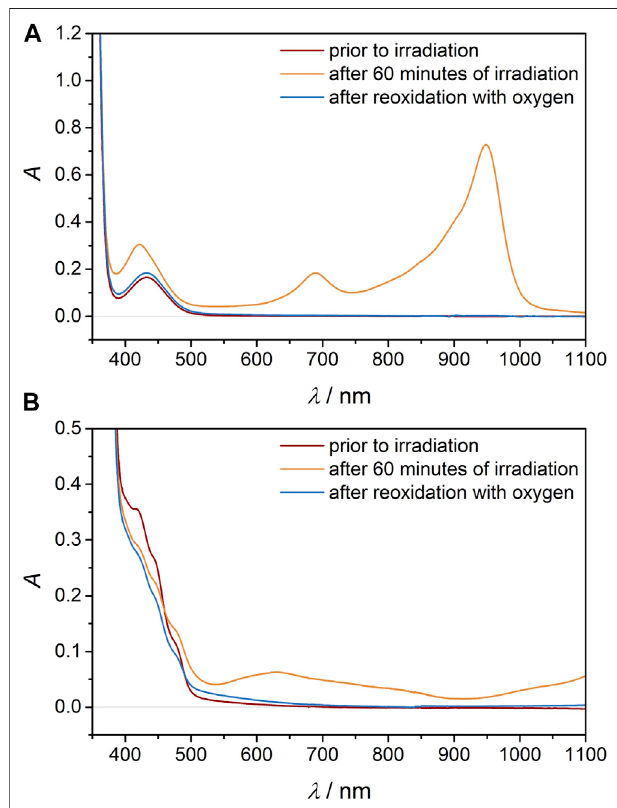
FIGURE 2 | UV/vis/NIR absorption spectra of (A) [Cr(tpe) 2 ] 3+ and (B) [Cr(dmcbpy) 3 ] 3+ in CH 3 CN prior to irradiation (red), after 60 min of LED irradiation ( λ exc = 460 nm) under argon in the presence of t An (orange) and after re-oxidation with air in the dark